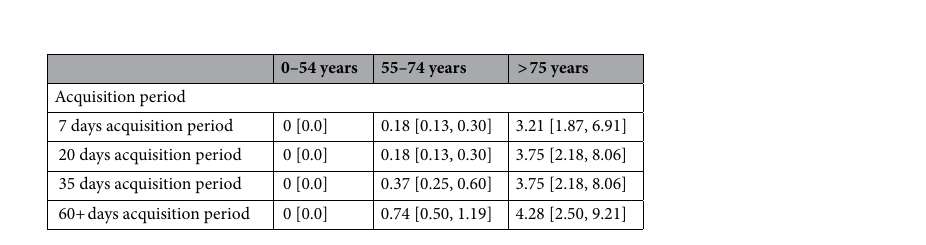
Table 2. Estimates of infection fatality rate (in %) and 95% confidence intervals in age strata with different acquisition